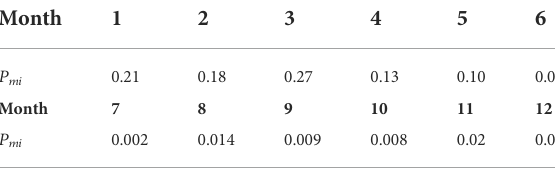
TABLE 3 Transaction dataset of 110 kV and above transmission lines.